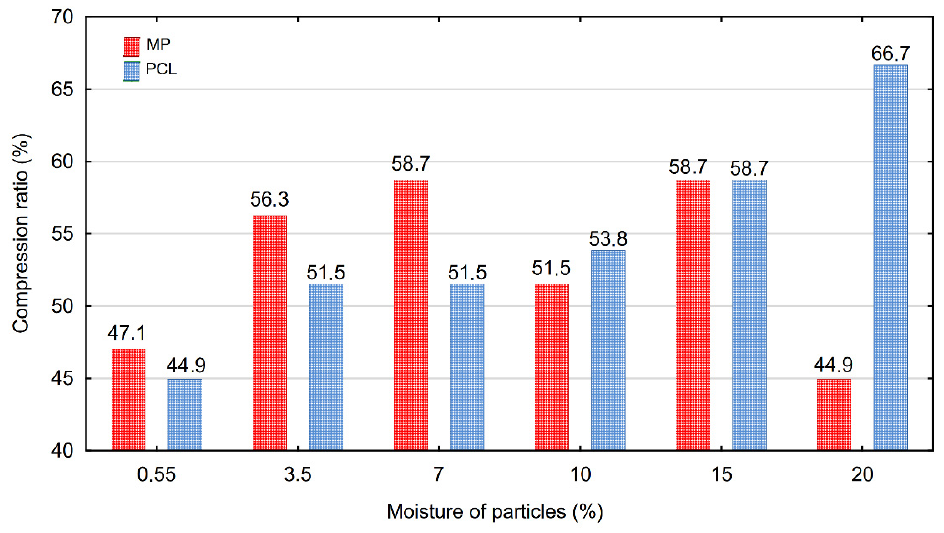
Figure 6. The compression ratio of wood particles depending on their moisture content.